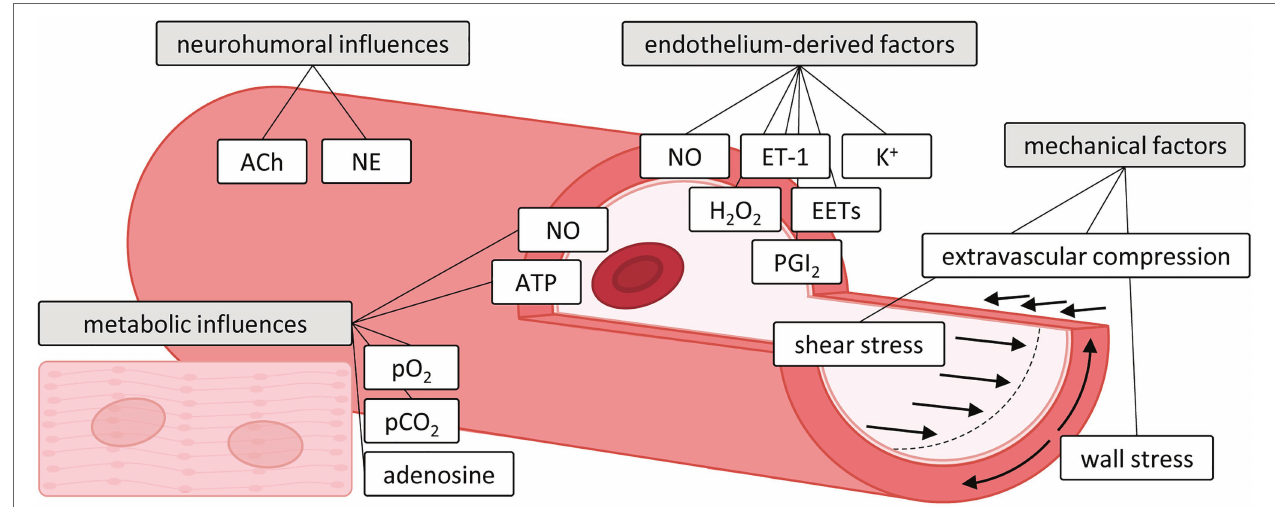
FIGURE 1 | Influences of metabolic, neurohumoral, endothelium-derived and mechanical factors on the microvasculature. Adapted with permission from Duncker and Bache (2008). ACh, acetylcholine; ATP, adenosine triphosphate; EETs, epoxyeicosatrienoic acids; ET-1, endothelin-1; H 2 O 2 , hydrogen peroxide; NE, norepinephrine; NO, nitric oxide; pCO 2 , dissolved carbon dioxide; PGI 2 , prostacyclin; pO 2 , oxygen